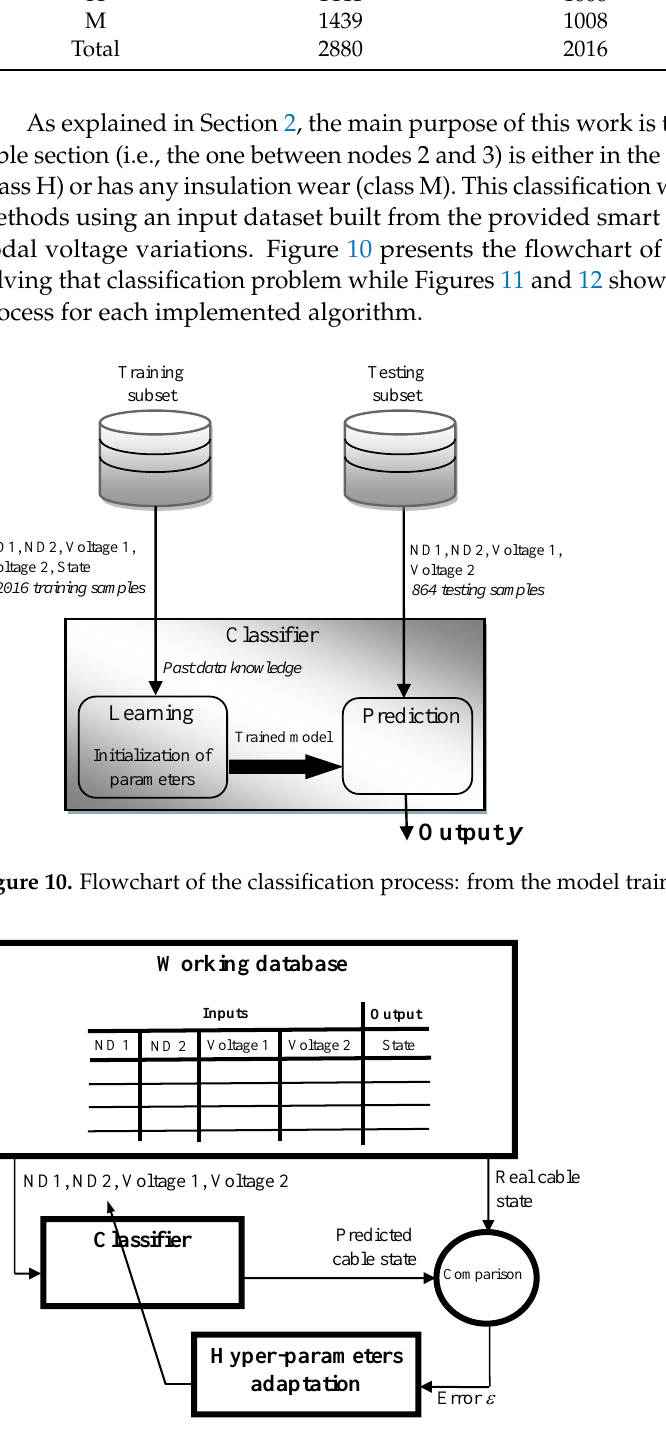
Figure 11. Classification process specified to decision tree (DT) and k-nearest neighbor (kNN) al- gorithms.